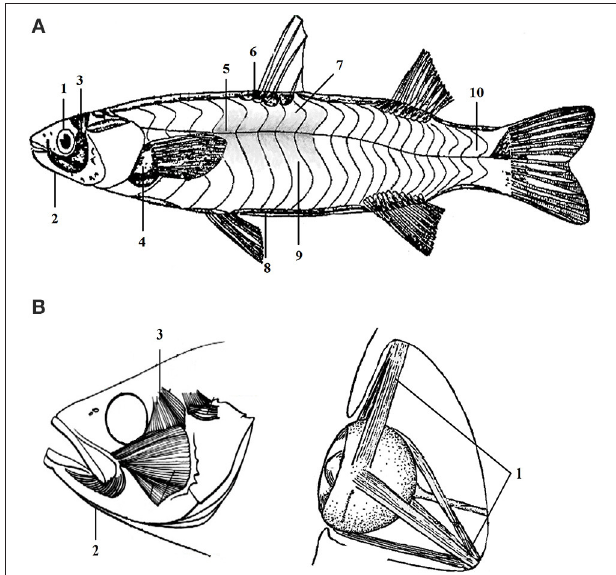
FIGURE 1 | The distribution of different positional muscle tissues of C. idellus . The different positional muscle samples tested in this study were collected from corresponding designated parts of C. idellus . General profile of the distribution of 10 positional muscles was shown in section (A) . Detailed distribution of muscles in head was described in section (B) . The part of fish body in light gray, is given only as a spatial reference (A). Corresponded to the muscle analyzed in present study, the gray part is superficial red muscle. The 10 numbers in (A) represent 10 positional muscles. 1-eyes muscle; 2-jaw muscle; 3-opercular muscle; 4-paired fins muscle; 5-red muscle; 6-odd fin muscle; 7-back muscle; 8-abdomen muscle; 9-rib muscle; 10-tail